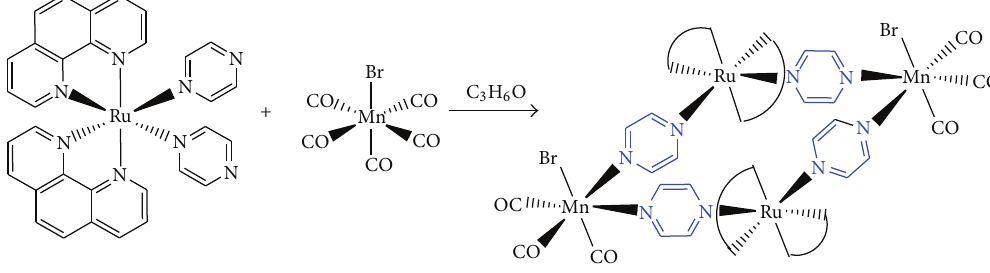
S 1: Synthesis of square complex I .